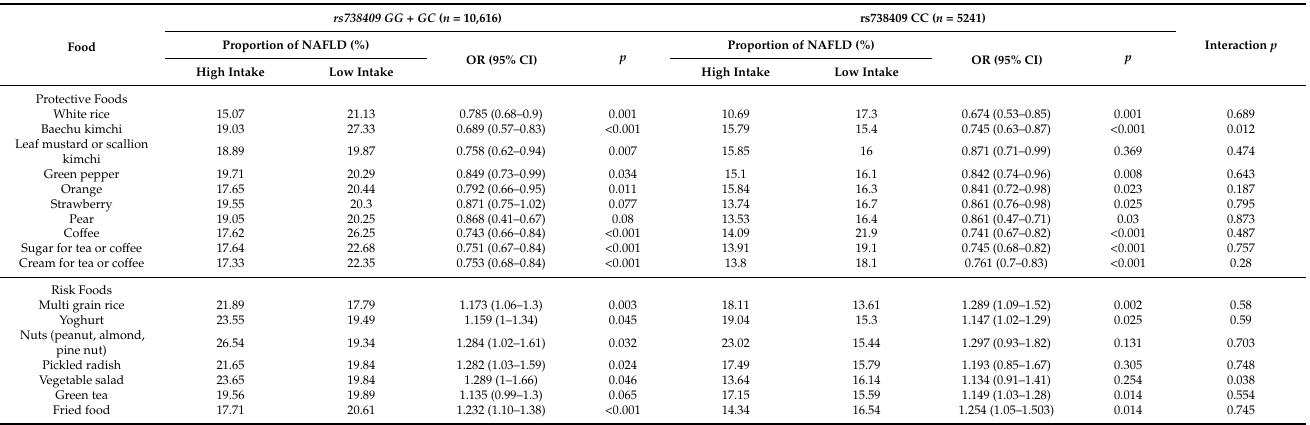
Table 5. Association and interaction between foods and the PNPLA3 genotype for the risk of non- alcoholic fatty liver disease (NAFLD) development. Multivariate logistic regression analyses adjusted for age, sex, and smoking were